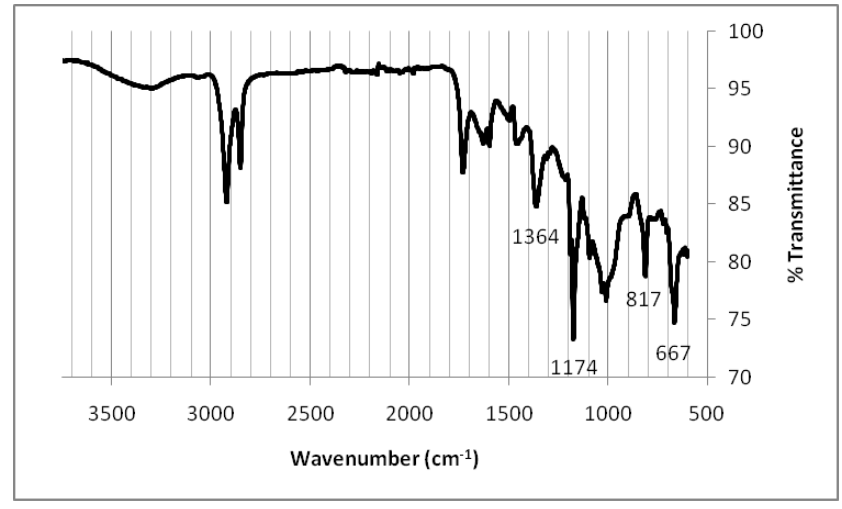
Figure 5. FTIR of the Tosylated SEGT.